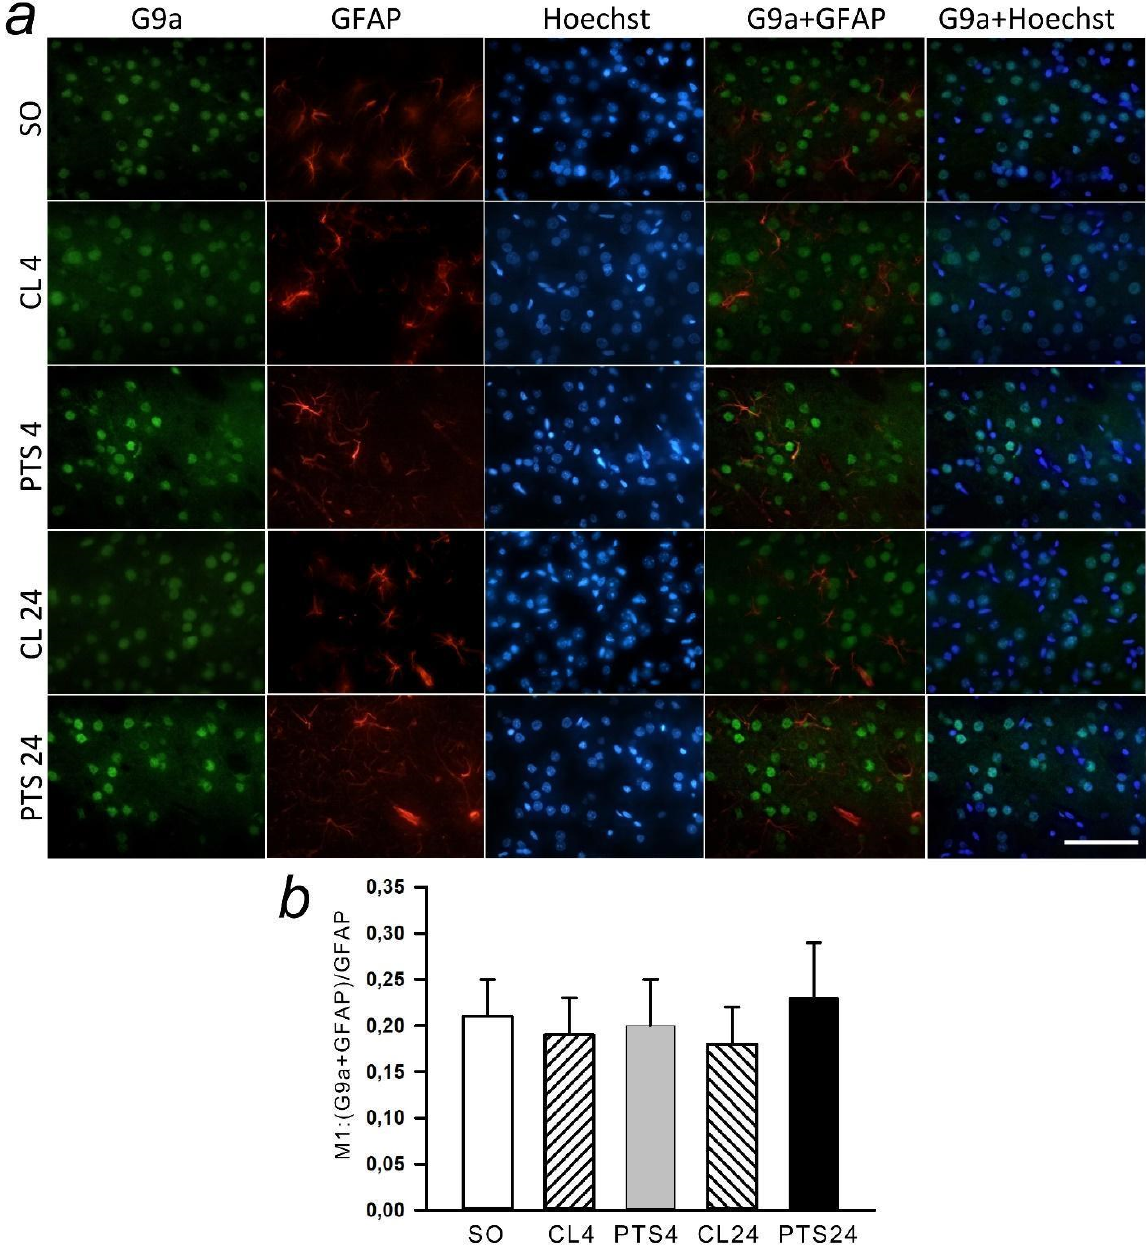
Figure 9. The changes of G9a levels in the astrocytes of ischemic penumbra 4 and 24 h after photothrombotic stroke (PTS) in the rat cerebral cortex. G9a levels (PTS4 and PTS24, respectively) compared to contralateral cortex of the same animals (CL4 and CL24), or the cortex of sham-operated rats (SO) are shown. ( a ) Immunofluorescence of G9a (green), marker of astrocytes GFAP (red), nuclear chromatin marker Hoechst 33342 (blue), and image overlay. The scale bar is 50 µ m. ( b ) Coefficient M1 of G9a co-localization with astrocyte marker (GFAP) in different control and experimental groups. One Way ANOVA; M ± SEM; n = 7.